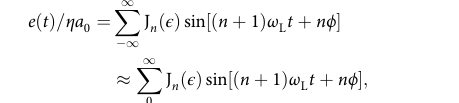
¼ y 0 α ¼ y 0 cos